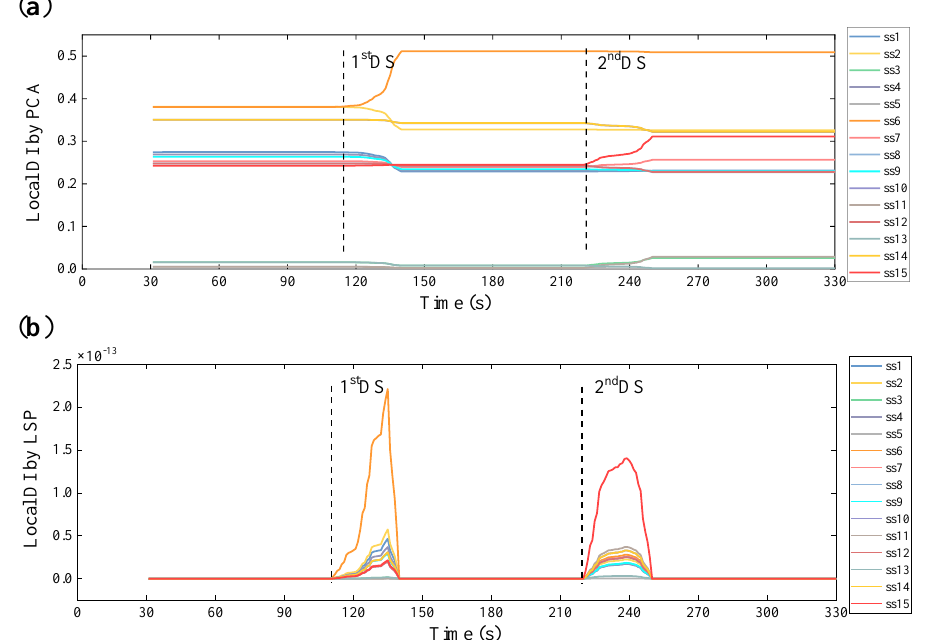
Figure 9. The temporal variation of local damage indicators based on the WPES-based ( a ) PCA and ( b ) LSP methods, respectively.